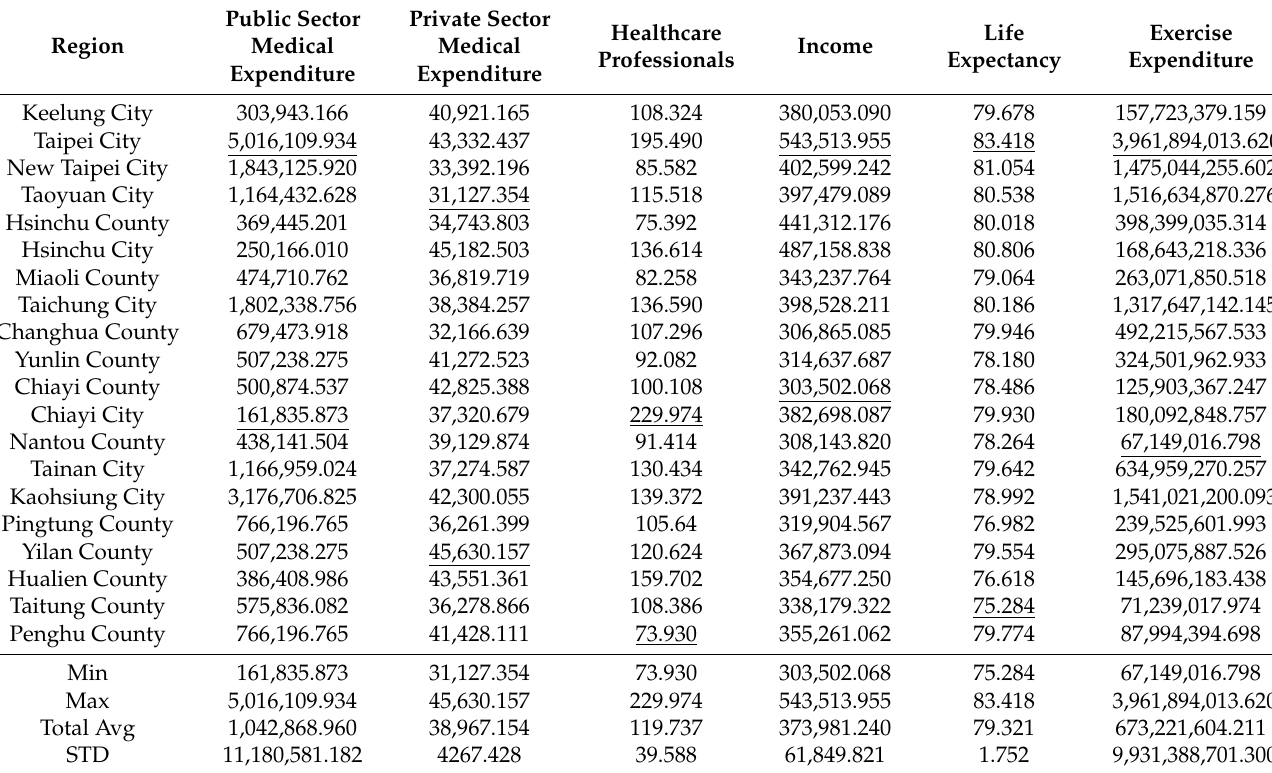
Table 3. Descriptive